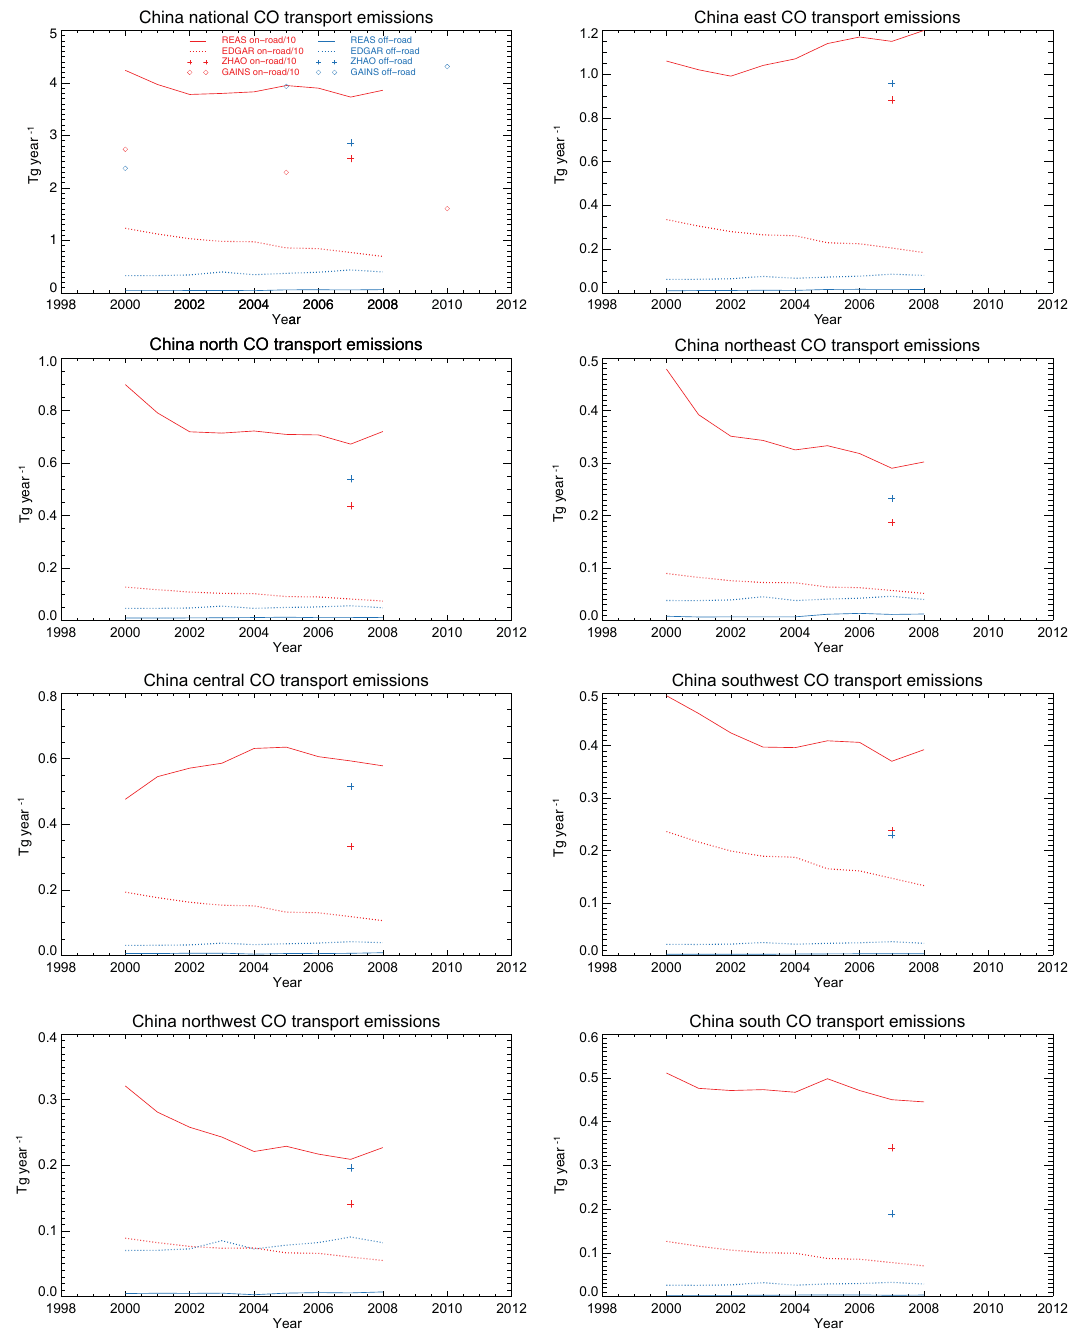
Figure 11. National and regional on-road and off-road transport sector emissions of CO estimated by REAS, EDGAR, ZHAO, and GAINS between 2000 and